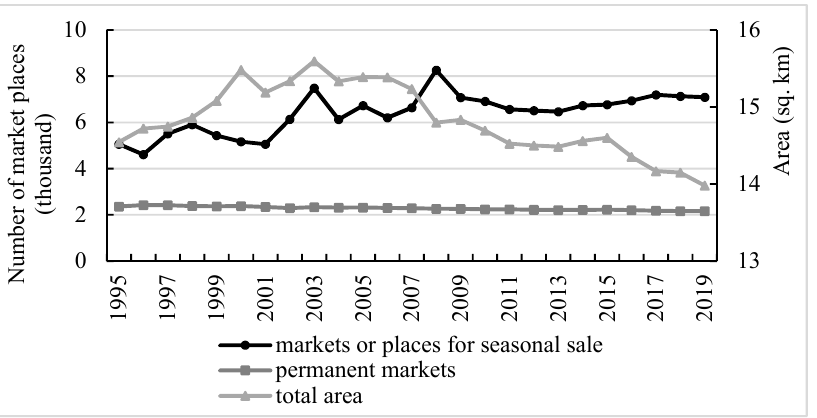
Figure 3. Number of marketplaces or places on streets and squares for seasonal sales and the area of markets in Poland in 1995–2019. Source: own elaboration based on data from the Local Data Bank.